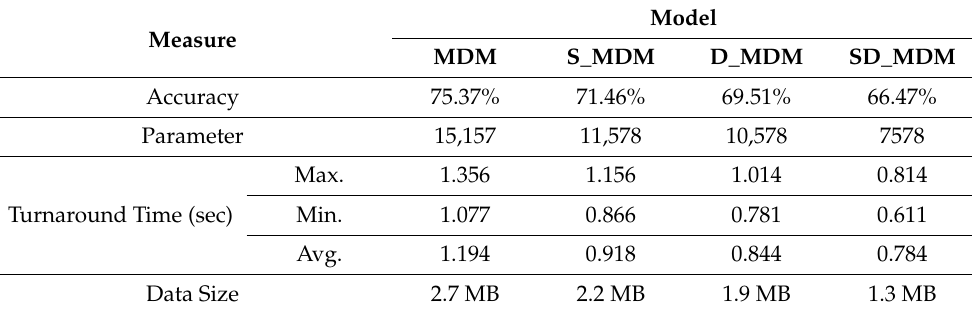
Table 7. Performance according to the sparse coding of multimodal deep learning